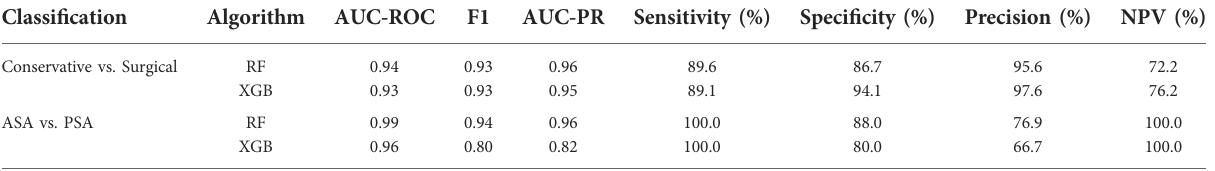
TABLE 4 Results of binary classi fi cations.